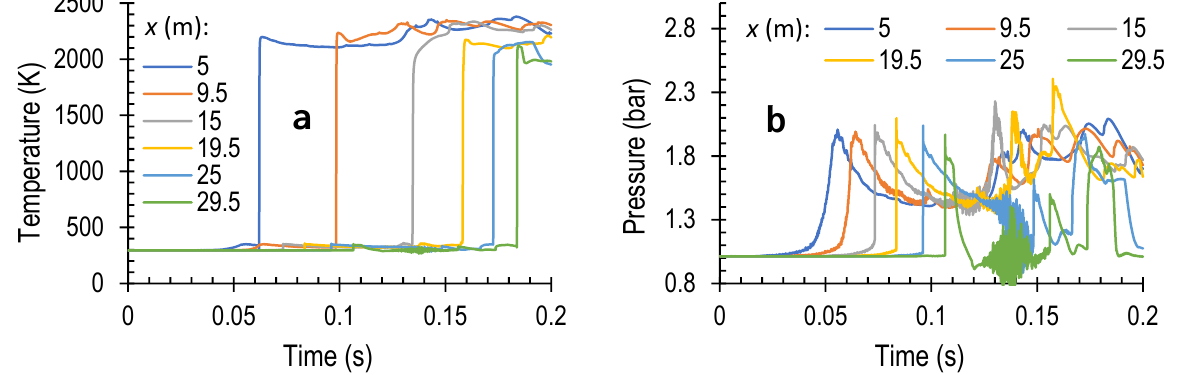
Figure 6. Local temperature ( a ) and pressure ( b ) monitored at different locations as a function of time in an empty tube.